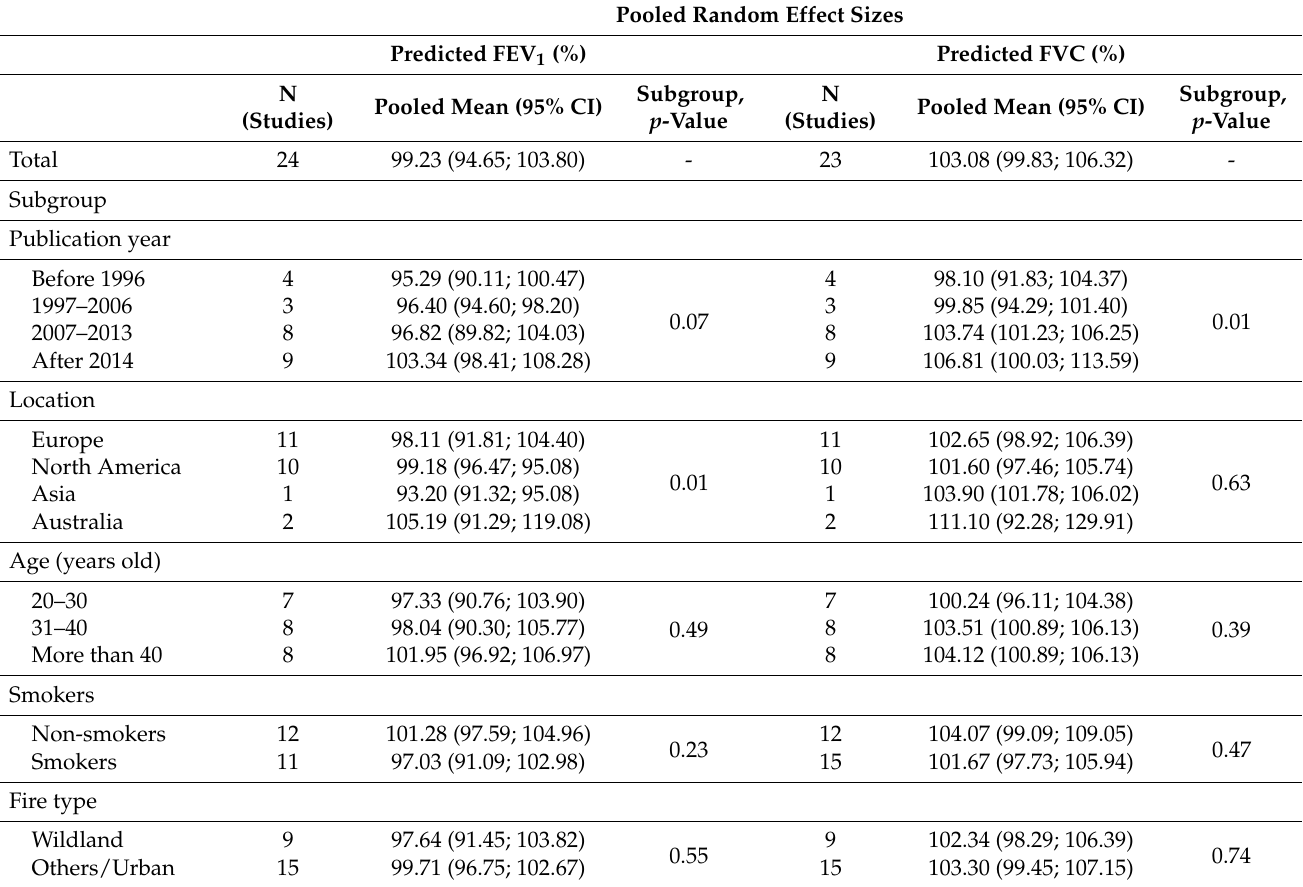
Table 2. Detailed results of the predicted FEV 1 and FVC parameters obtained in the